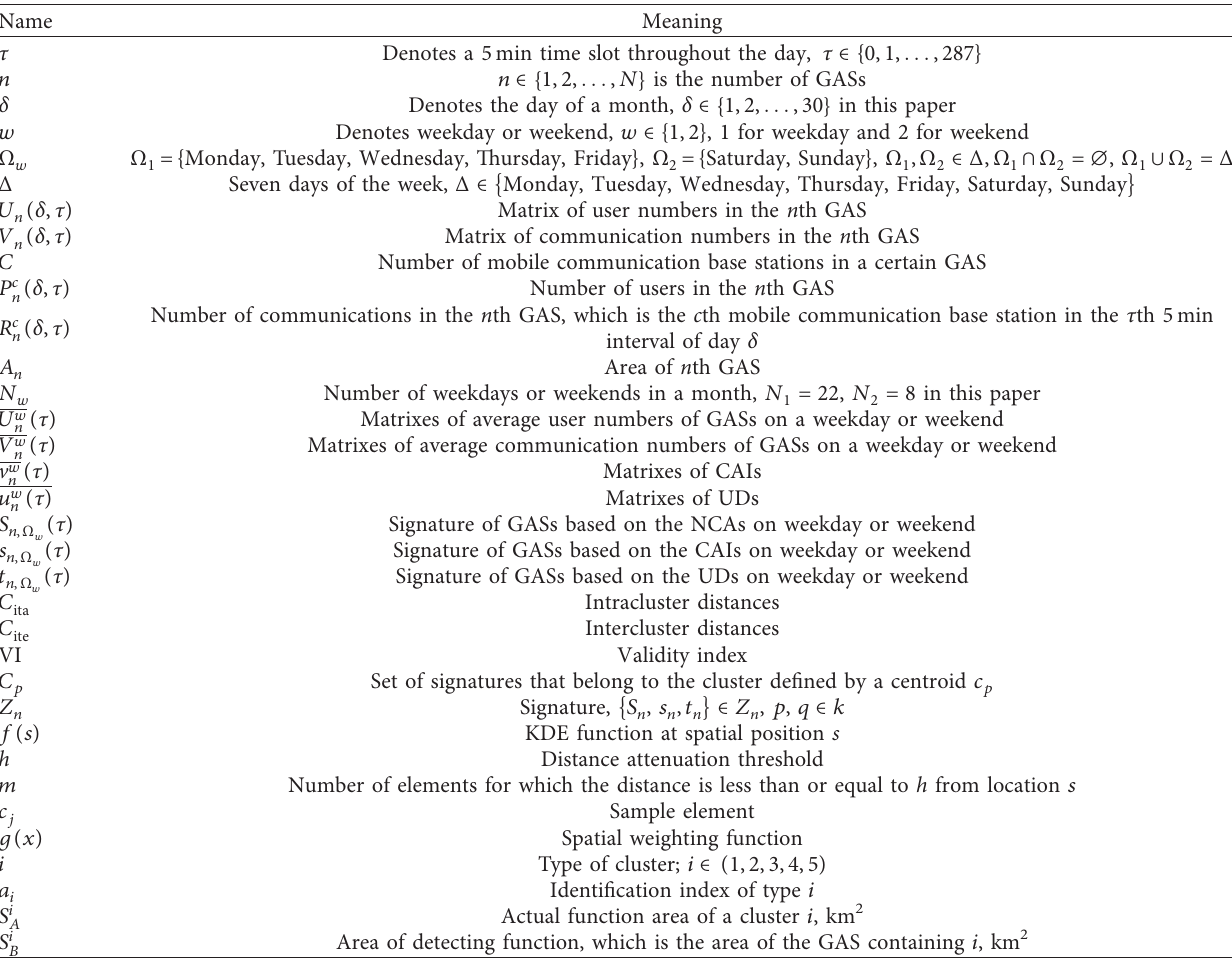
Table 4: Parameter